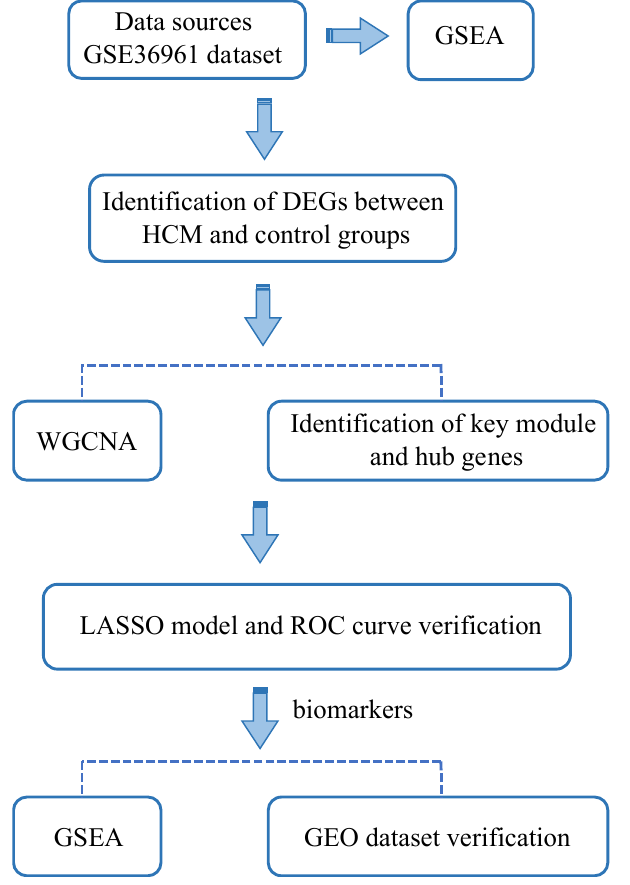
Figure 1. Workflow to identify potential biomarkers and biological pathways in hypertrophic cardiomyopathy (HCM). We firstly obtained differentially expressed genes (DEGs) from GSE36961 dataset, and then conducted WGCNA, LASSO, and GSEA step by step to find potential biomarkers and biological pathways in HCM.